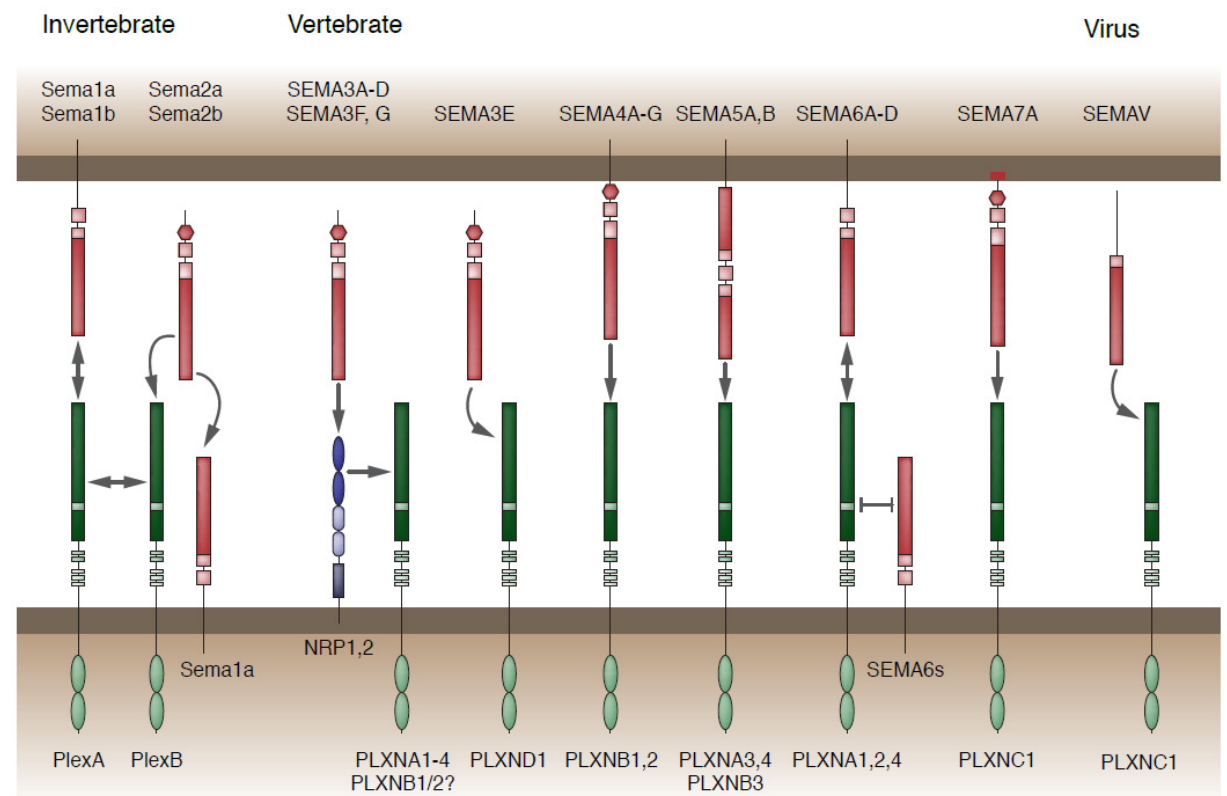
Figure 1. Semaphorins (SEMA/Sema) and Plexins (PLXN/Plex) diversity. Sema2s, SEMA3s and SEMAV are secreted proteins, while the others are membrane anchored (SEMA7A presents an additional glycosylphosphatidylinositol). Sema1s, Sema2s and Sema5c (not pictured here as its function is unknown) are present in invertebrates, while SEMAV is found in viral genome. All the remaining (SEMA3s to SEMA7A) are vertebrate Semaphorins. In the nervous system, Semaphorins are signaling directly through Plexins. Exception is made for SEMA3A, SEMA3B, SEMA3C, SEMA3D, SEMA3F and SEMA3G which are bound by Neuropilins (NRP) 1 or 2, and form a receptor complex with PLXNAs to initiate an intracellular pathway.